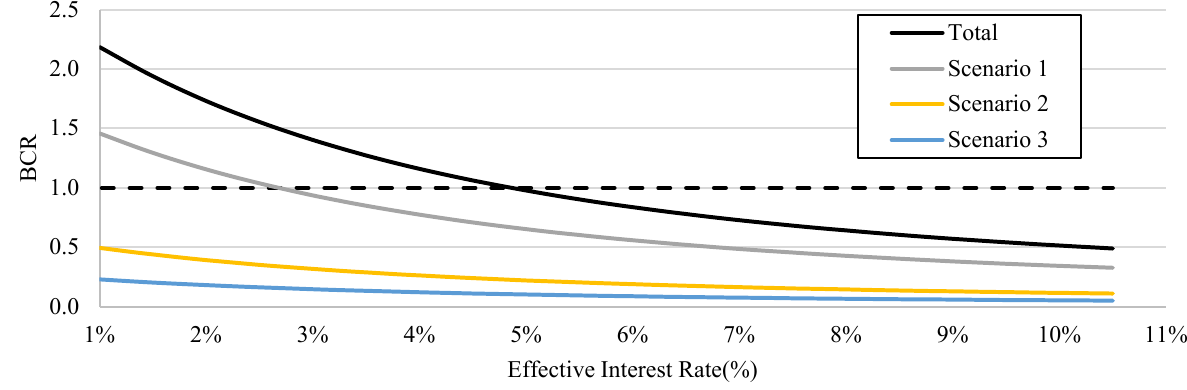
Figure 16. Total benefit/cost ratio for all three scenarios.